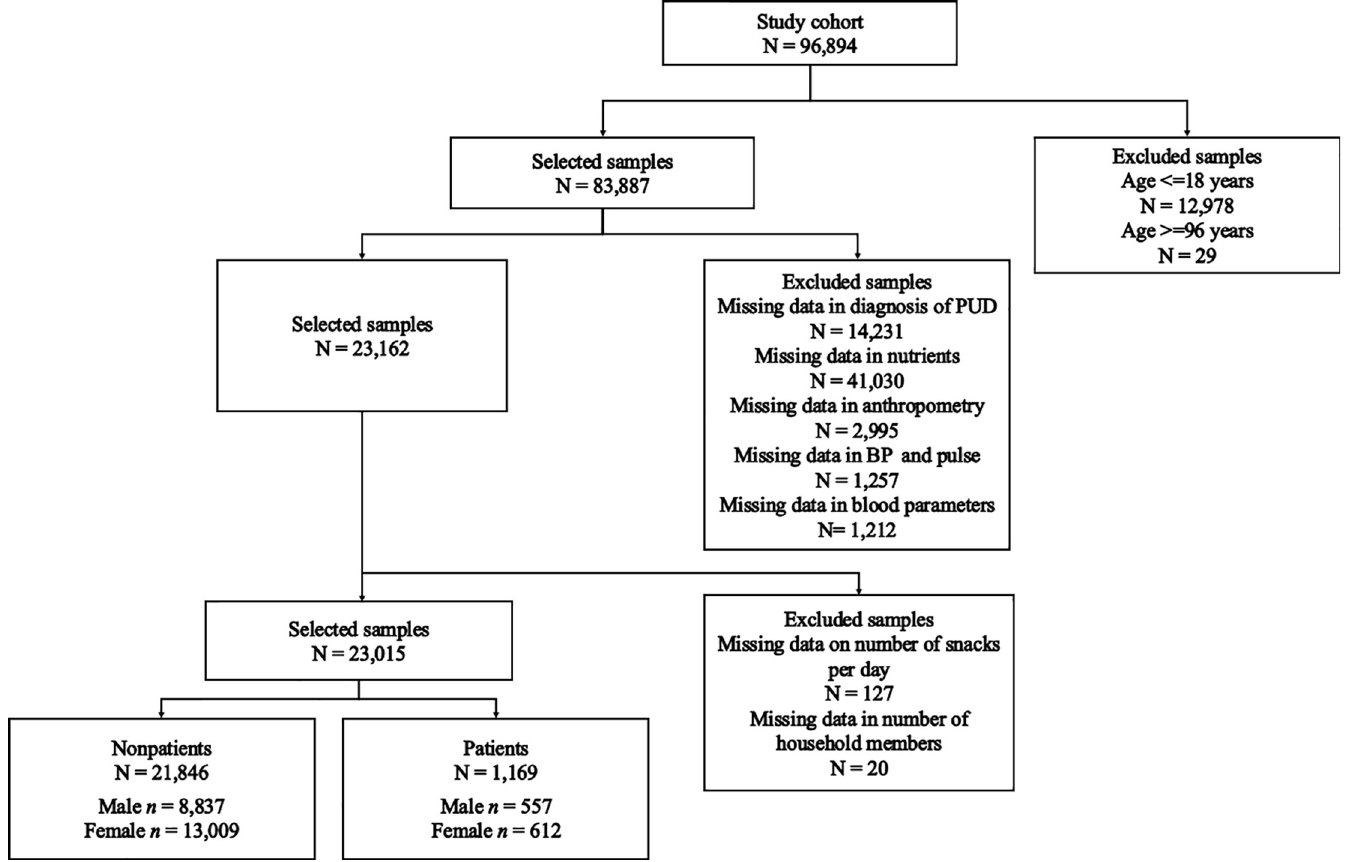
Fig 1. Sample selection procedure. PUD: peptic ulcer disease; BP: blood pressure.